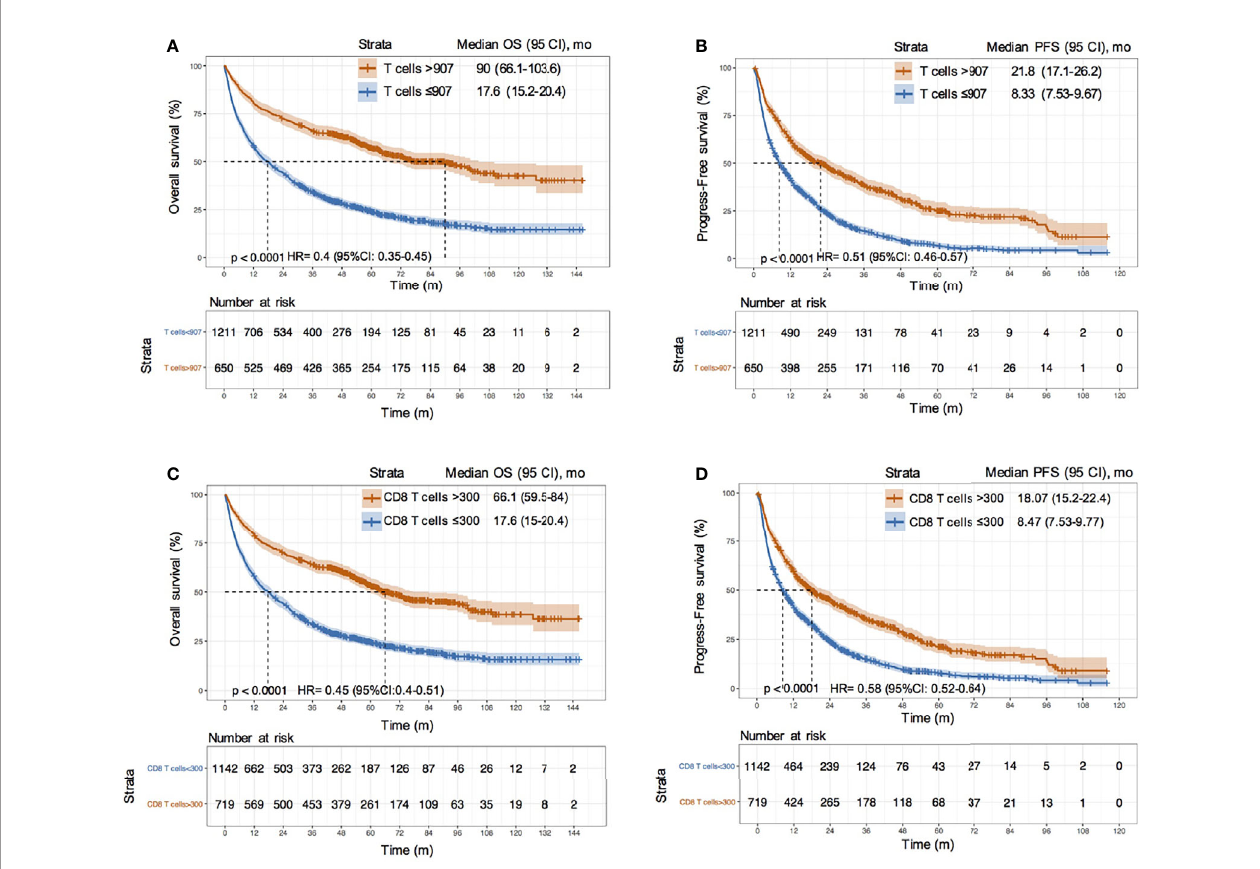
FIGURE 5 | Survival analysis between HCC patients with different T cell and CD8 T cell counts. (A, B) KM curves of OS and PFS between HCC patients with T cells > 907/ m L and ≤ 907/ m L in training cohort; (C, D) KM curves of OS and PFS between HCC patients with CD8 T cells > 300/ m L and ≤ 300/ m L in training